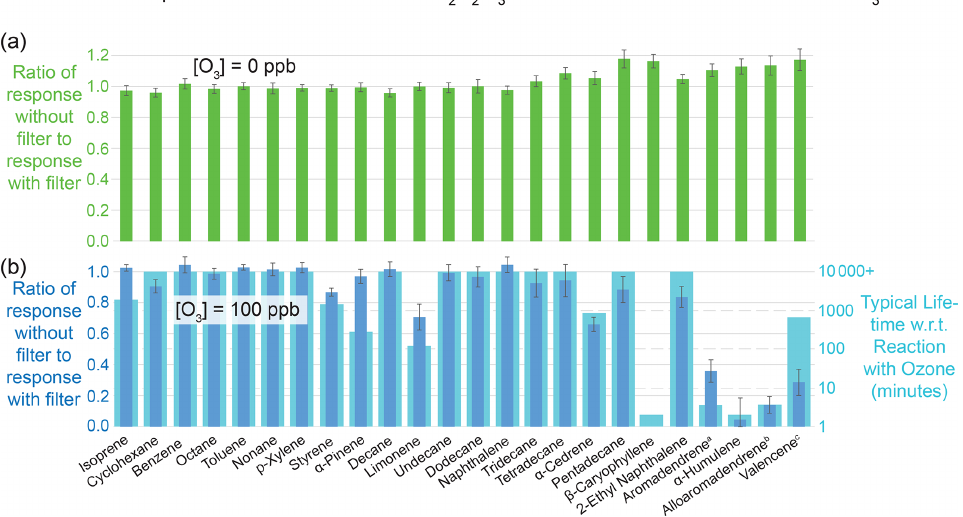
Figure 5. Results of evaluation of effectiveness of sodium thiosulfate filter in mitigating the effects of ozone on reactive analytes during collection of VOCs and IVOCs. Error bars represent plus or minus 1 standard deviation of six replicate measurements. Panel (a) confirms that in the absence of ozone, the filter does not affect the detected quantities of each compound, except for slight ( < 15%) losses of IVOCs with the filter present, leading to response ratios greater than 1. Panel (b) demonstrates that the filter prevents substantial losses of reactive species in the presence of ozone, confirming that without preventive measures ozone can significantly deplete certain analytes. Values are compared with published lifetimes with respect to reaction with ozone, with overall qualitative agreement. Published lifetimes are from Atkinson and Arey (2003) unless above 10000min or otherwise indicated. (a) Pollmann et al. (2005). (b) No published experimental value, assumed reactivity equal to that of the stereoisomer aromadendrene. (c) Ham